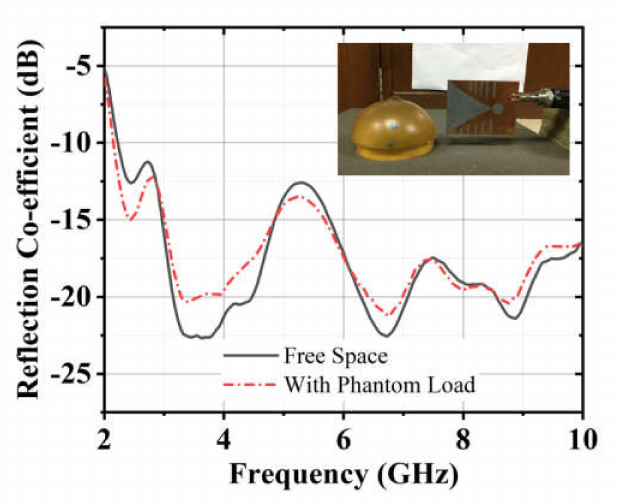
Figure 4. Measured reflection coefficient in free space and a phantom load.